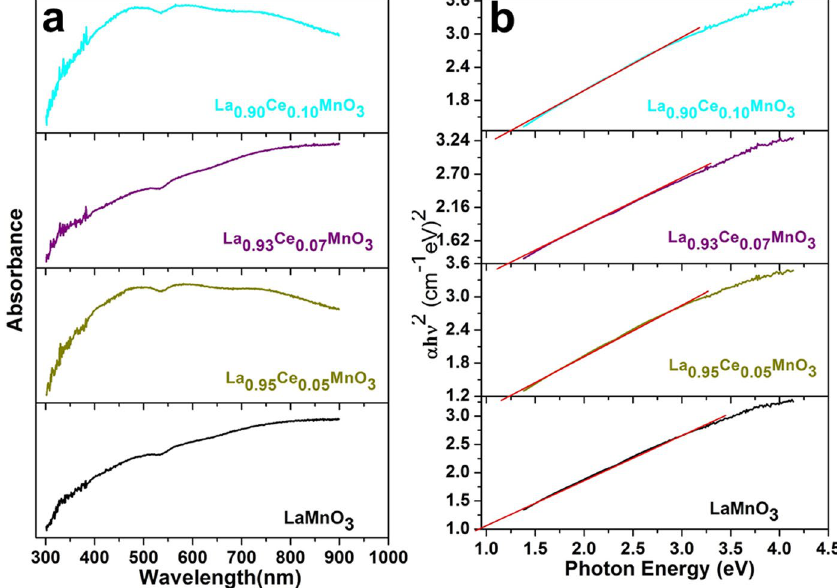
Figure 5. ( a) UV/Vis absorption spectra and ( b ) The plot of ( α h ν ) 2 vs. photon energy(h ν ) LaMnO 3 ,